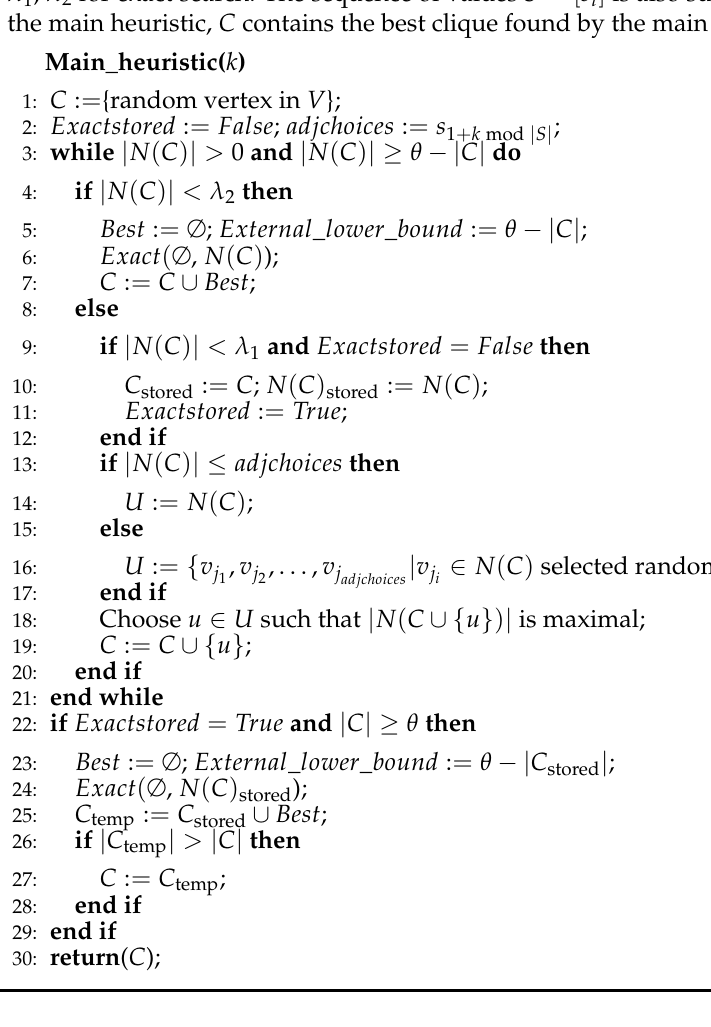
Algorithm 3: Main heuristic at iteration k . The algorithm is invoked for a graph G = ( V , E ) with C : = {random vertex in V }. Parameters supplied are the threshold θ from Algorithm 2, and two further thresholds λ 1 , λ 2 for exact search. The sequence of values S = [ s i ] is also supplied. Following the call to the main heuristic, C contains the best clique found by the main heuristic at iteration k